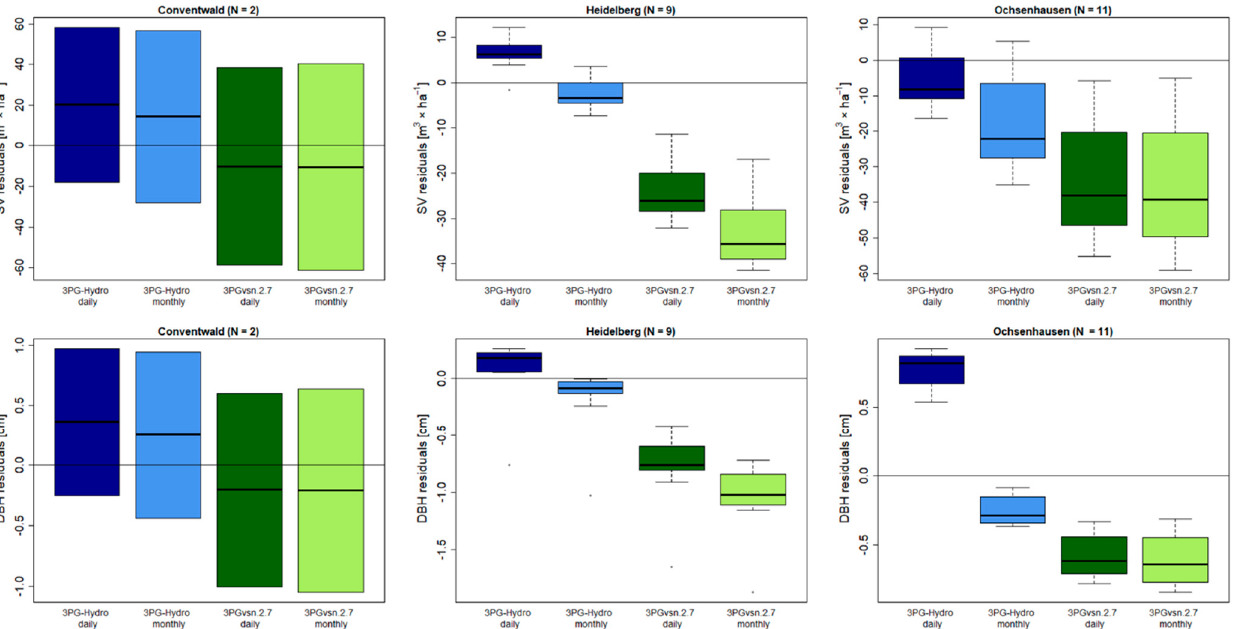
Forests 2021 , 12 , x FOR PEER REVIEW 12 of 26 Figure 3. Residual plots (observed data—simulated data) for growth (SV and DBH) influenced by thinning events. Simulated with 3PG Hydro daily, 3PG-Hydro monthly, 3PG vsn. 2.7 daily and 3PG vsn. 2.7 monthly.